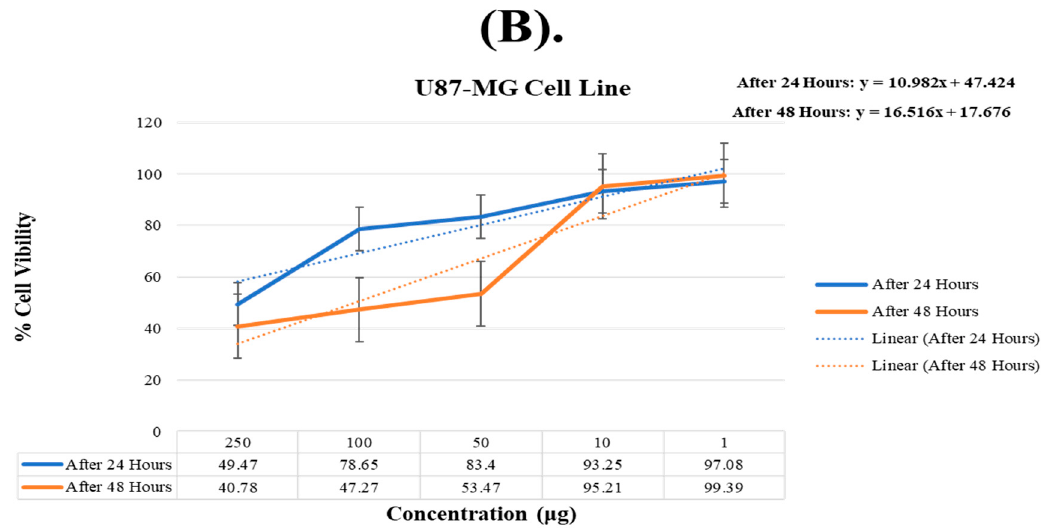
Figure 10. Graphical presentation of % cell viability. ( A ). U87-MG cell line ( B ). HEK cell lines.